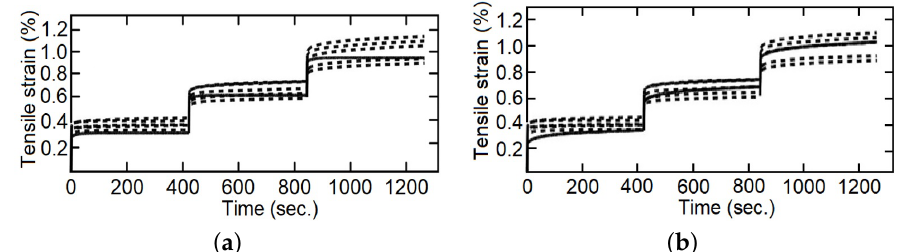
Figure 12. Tensile strain for staggered fluency test, five specimens with 14 wt%, experimental data in dotted lines and model response in continuous line, ( a ) integer index model, ( b ) fractional index model.